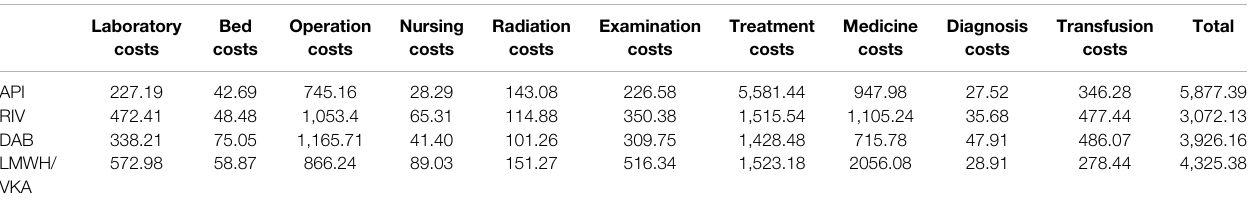
TABLE 3 | Results of EMR data for hospitalization costs.